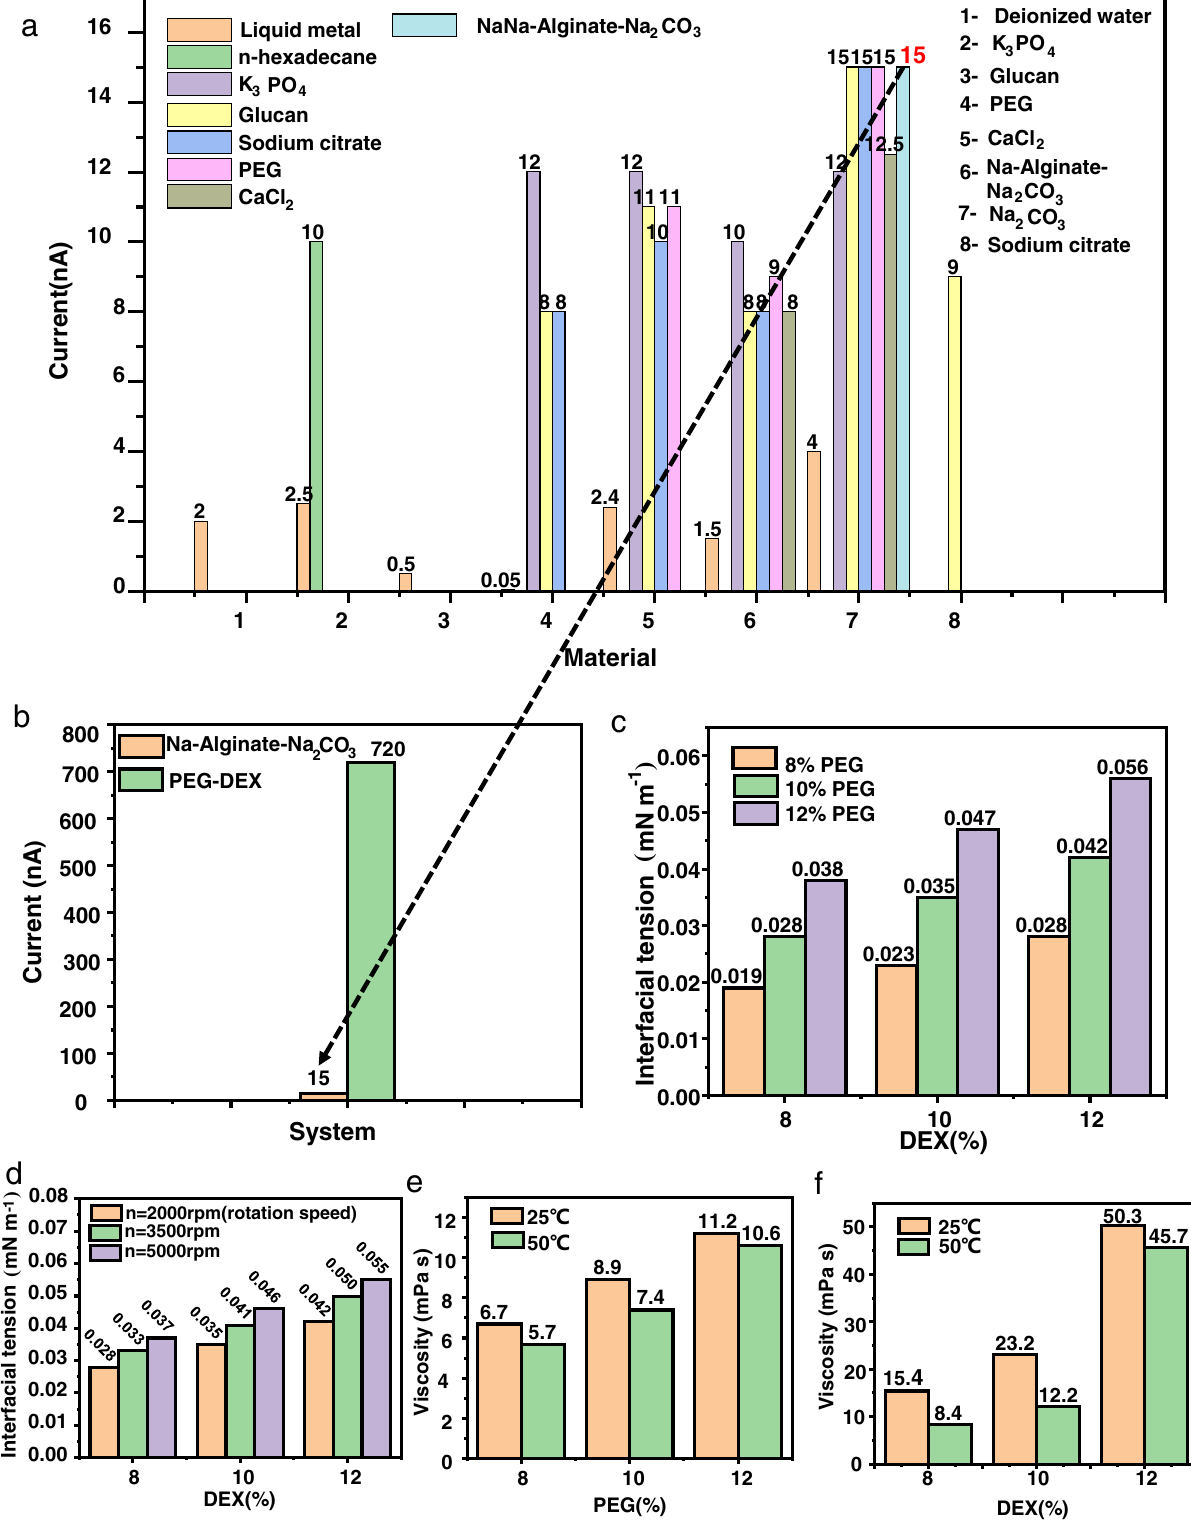
Fig. 2 | Miscibility and output between various aqueous two-phase systems. a Output signal from contact separation of multiple liquid systems. b The output contrast between the PEG-DEX and NaA – Na 2 CO 3 systems. c Surface tension